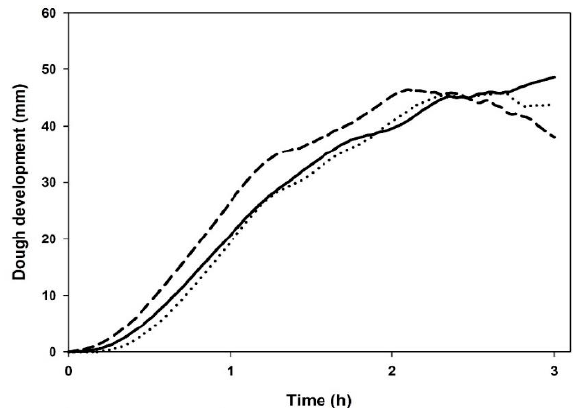
Figure 6. Dough development profiles of commercial wheat flour (solid line); with bran from un-sprouted wheat (dotted line) or bran from sprouted wheat (dash line).